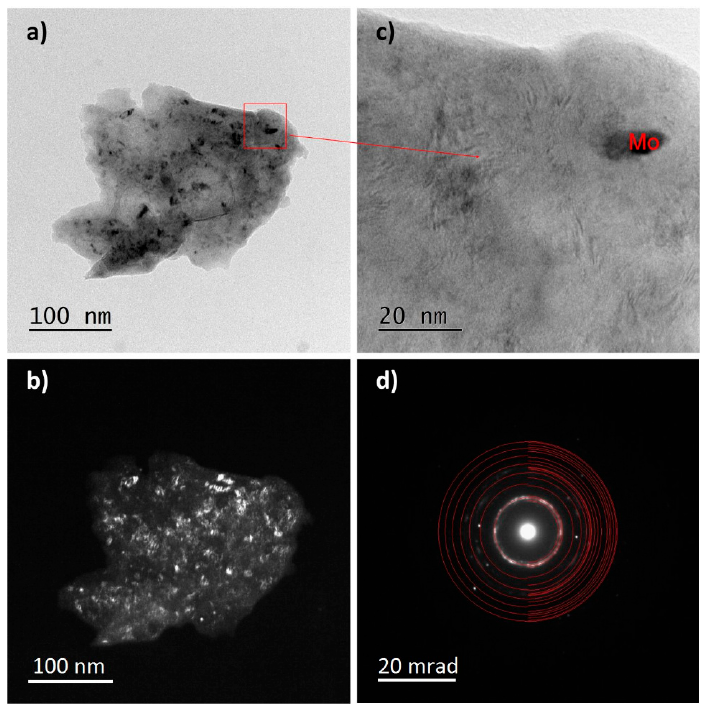
Figure 9. TEM analysis of the TTM powder milled for 100 h; ( a ) TEM bright ‐ field image; ( b ) TEM dark ‐ field images; ( c ) HR ‐ TEM image; and ( d ) SAED pattern of the α and β phases. Materials 2020 , 13 , x FOR PEER REVIEW